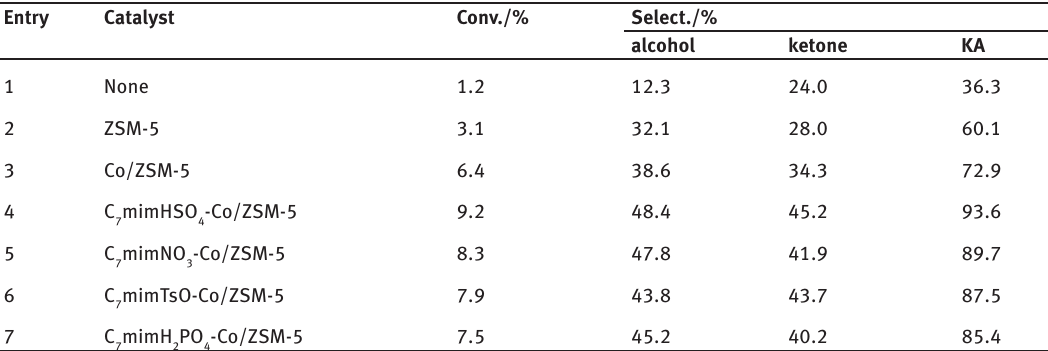
Table 3: Effect of catalyst on the aerobic oxidation of cyclohexane a . Entry Catalyst Conv./%